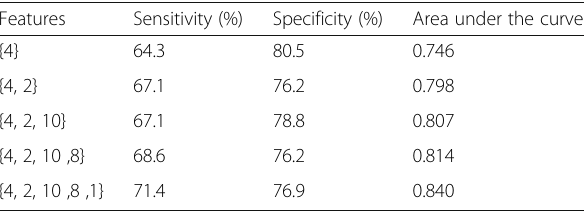
Table 6 Performance of different feature combinations using the support vector machine method Features